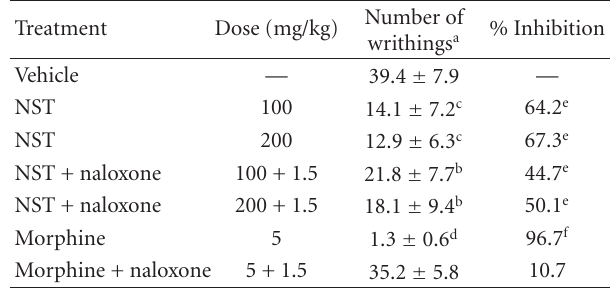
Table 1: E ff ect of NST or morphine on acetic acid-induced writhing.